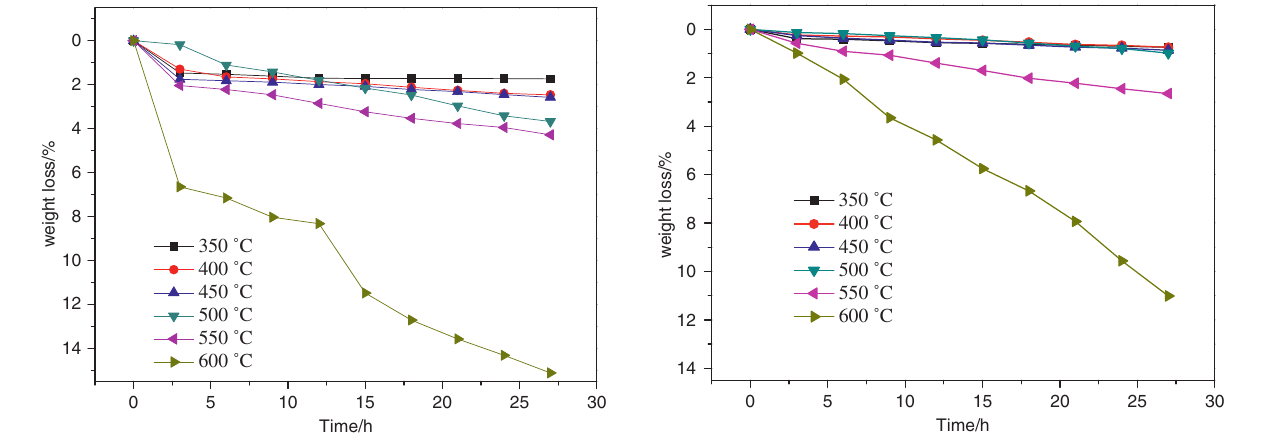
Figure 3: Weight loss vs time of potassium nitrate molten salt at different temperatures.